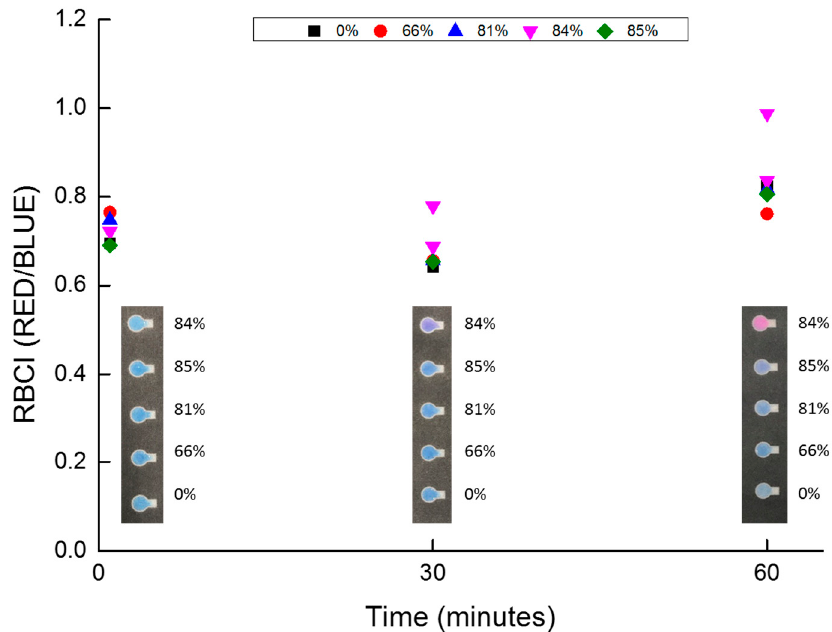
Figure 2. Relationship between RBCI and treatment time for the resazurin assay. Percentages in the square are motility of porcine sperm.